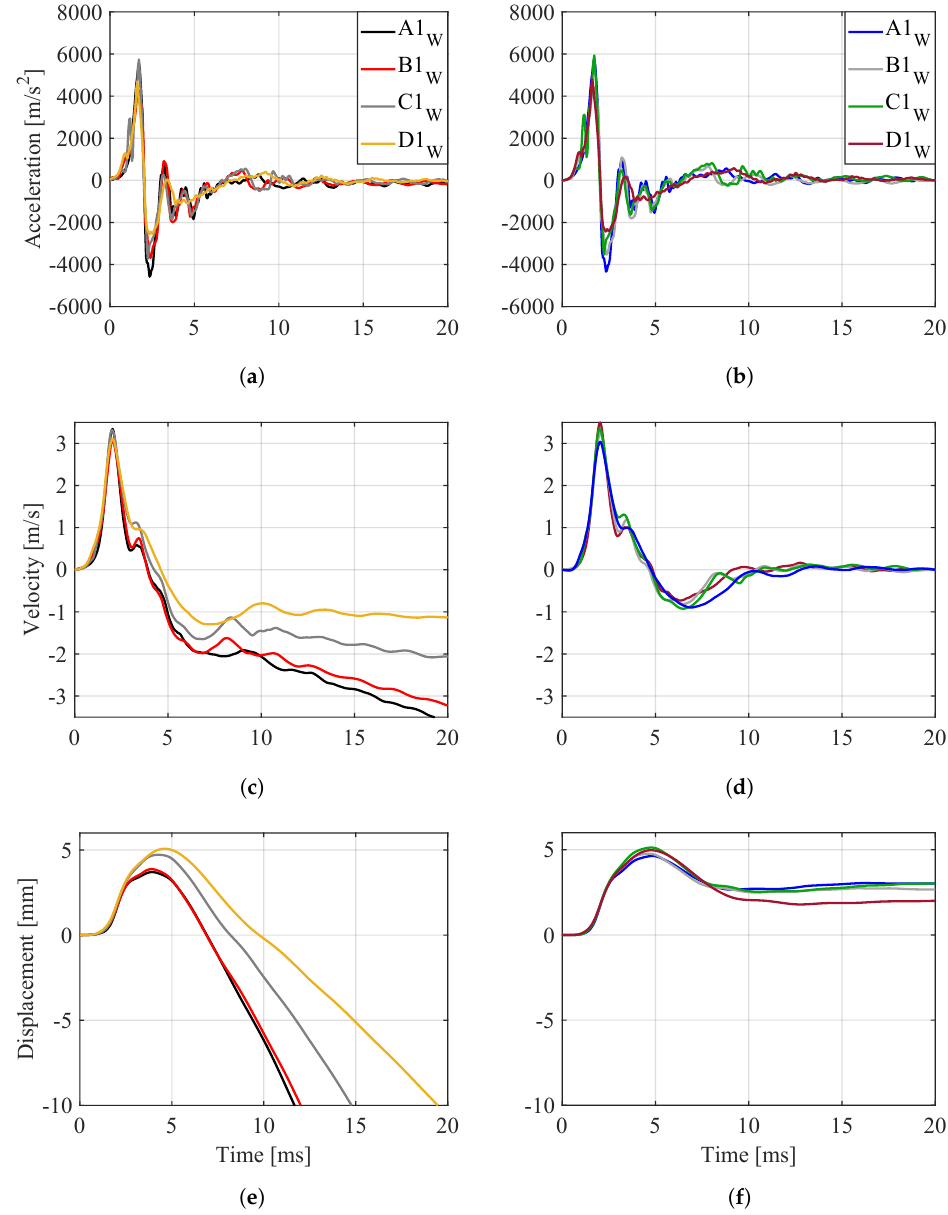
Figure 6. ( a ) Measured acceleration at the west accelerometer for A1–D1; ( b ) acceleration after signal processing; ( c ) velocity due to measured signal; ( d ) velocity after signal processing; ( e ) displacement due to measured signal; and ( f ) displacement after signal